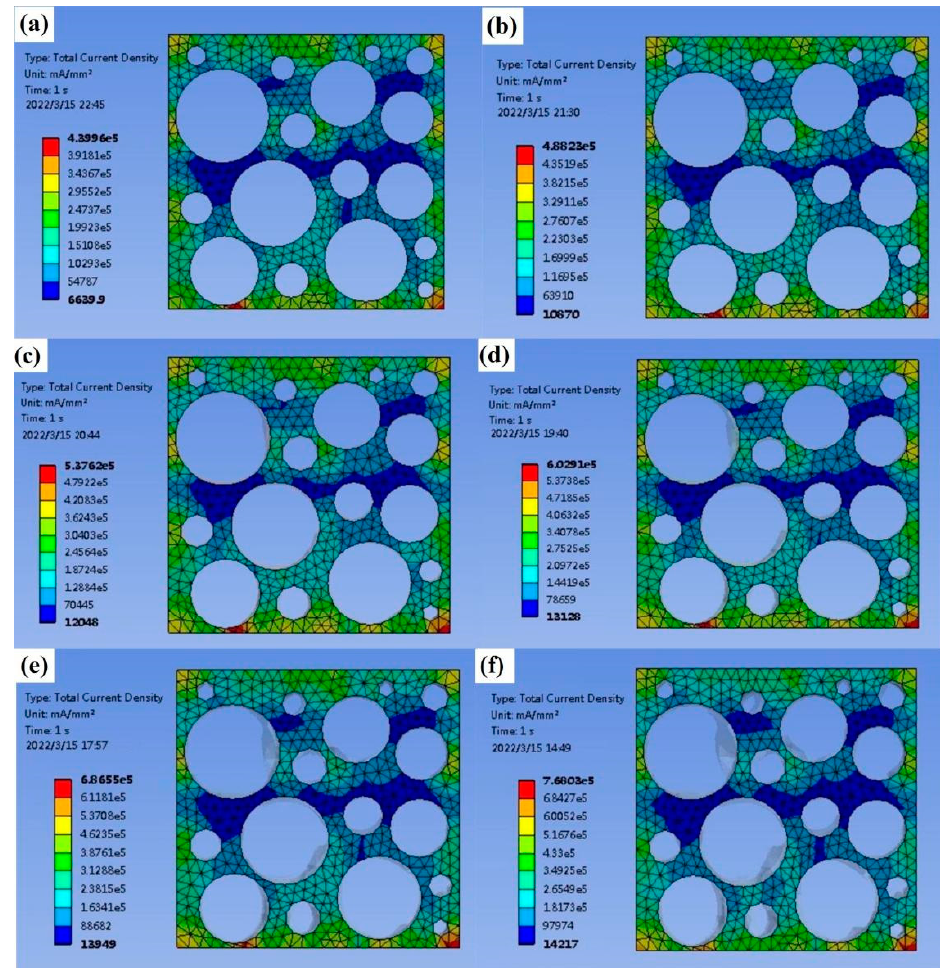
Figure 7. Current density of sponges with different deformations: ( a ) no deformation, ( b ) 5%, ( c ) 10%, ( d ) 15%, ( e ) 20%, and ( f ) 25%.